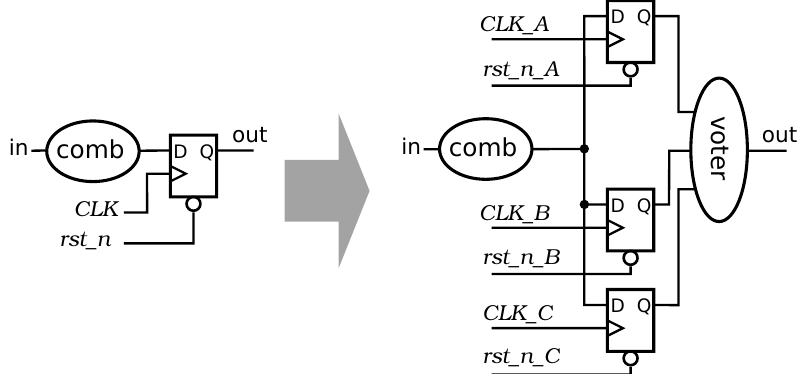
Figure 7. Triple Modular Redundancy (TMR) procedure applied in the